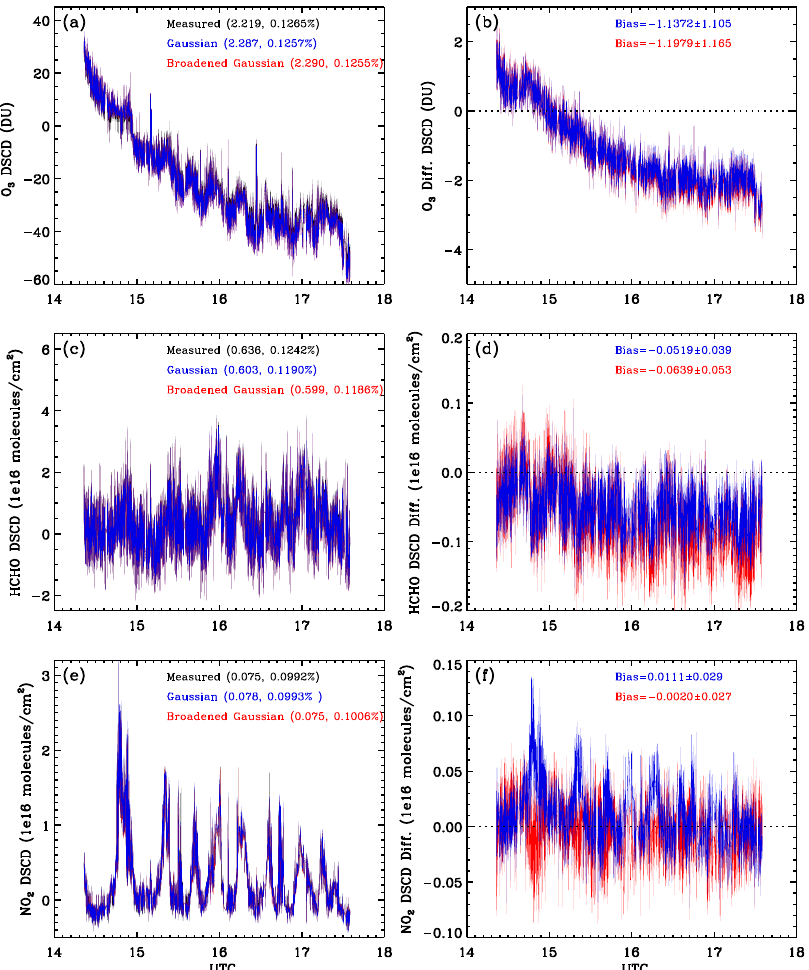
Figure 6. (Left) Comparison of fittings of O 3 , CH 2 O, and NO 2 : differential (relative to average nadir references) slant column densi- ties (DSCDs) from 21 July 2011 using derived Gaussian (blue) and broadened Gaussian (red) and measured (black) slit functions; (right) the DSCD differences between derived and measured slit functions (derived–measured). The legends show average fitting precisions together with mean fitting residuals for left panels and mean biases and their standard deviations for right